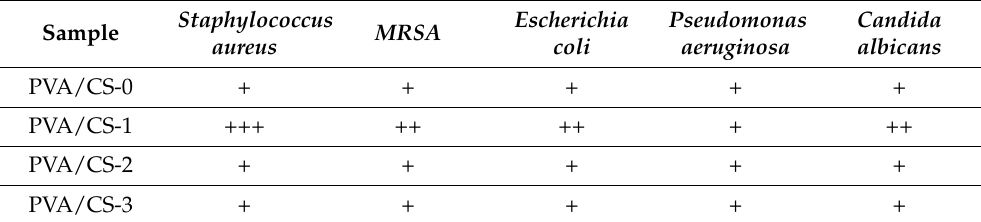
Table 3. Qualitative evaluation of the antimicrobial activity of APV-chitosan-PFR-TiO 2 matrices. Escherichia Pseudomonas Candida Staphylococcus MRSA Sample coli aeruginosa albicans aureus PVA/CS-0 + + + +